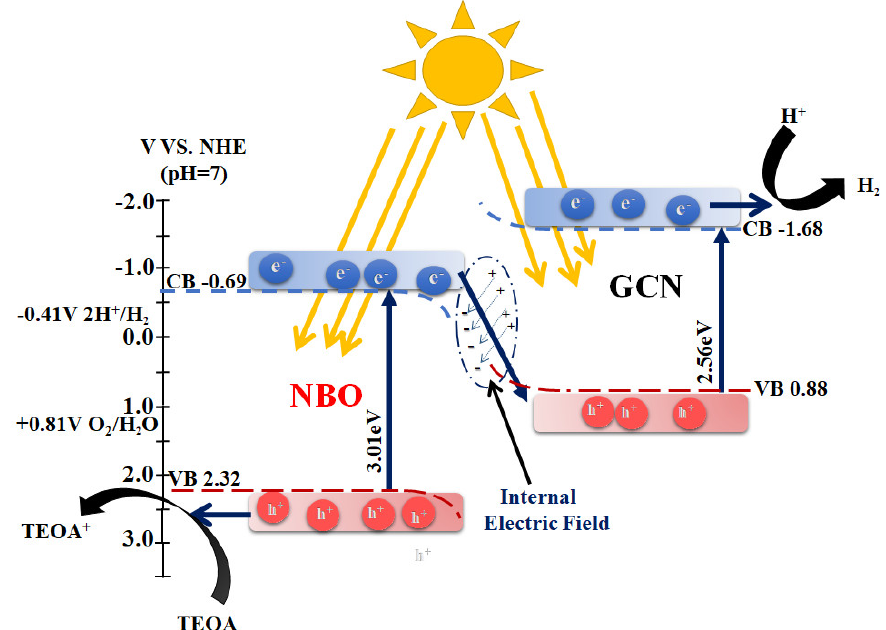
Figure 10. Schematic illustration of possible photocatalytic mechanism.